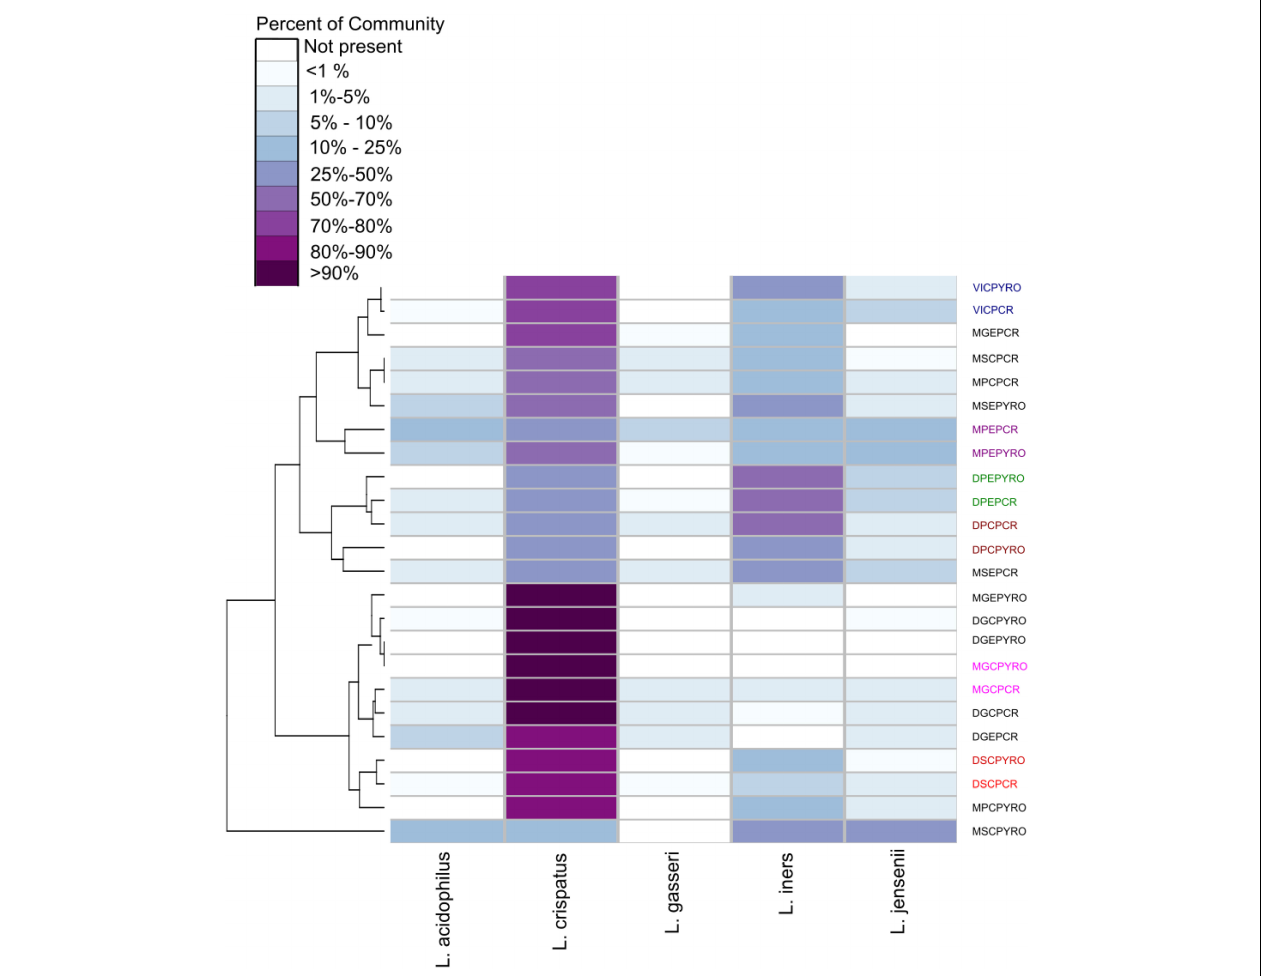
FIGURE 3 | Hierarchical clustering/distance ordination quantifying similarities between qPCR and NGS pairs. Lactobacillus relative abundance distribution and hierarchical clustering in NGS and qPCR analyzed samples. The heatmap shows relative abundances of detected Lactobacillus species in each sample, with columns organized by relative positions in the dendrogram and grouped by condition being investigated (M, menorrhagia; D, dysmenorrhea; virgo intacta, V), menstrual cycle phase (M, menstrual; secretory, S; proliferative, P; progestin effect, G), and sampling site (endocervix, C; endometrium, E). Some subsets of paired NGS and qPCR samples have been colored to highlight clustering. The sample abbreviations are comprised of two parts: the clinical information and the molecular technique (PYRO or qPCR). The clinical abbreviations can be found in Table 1